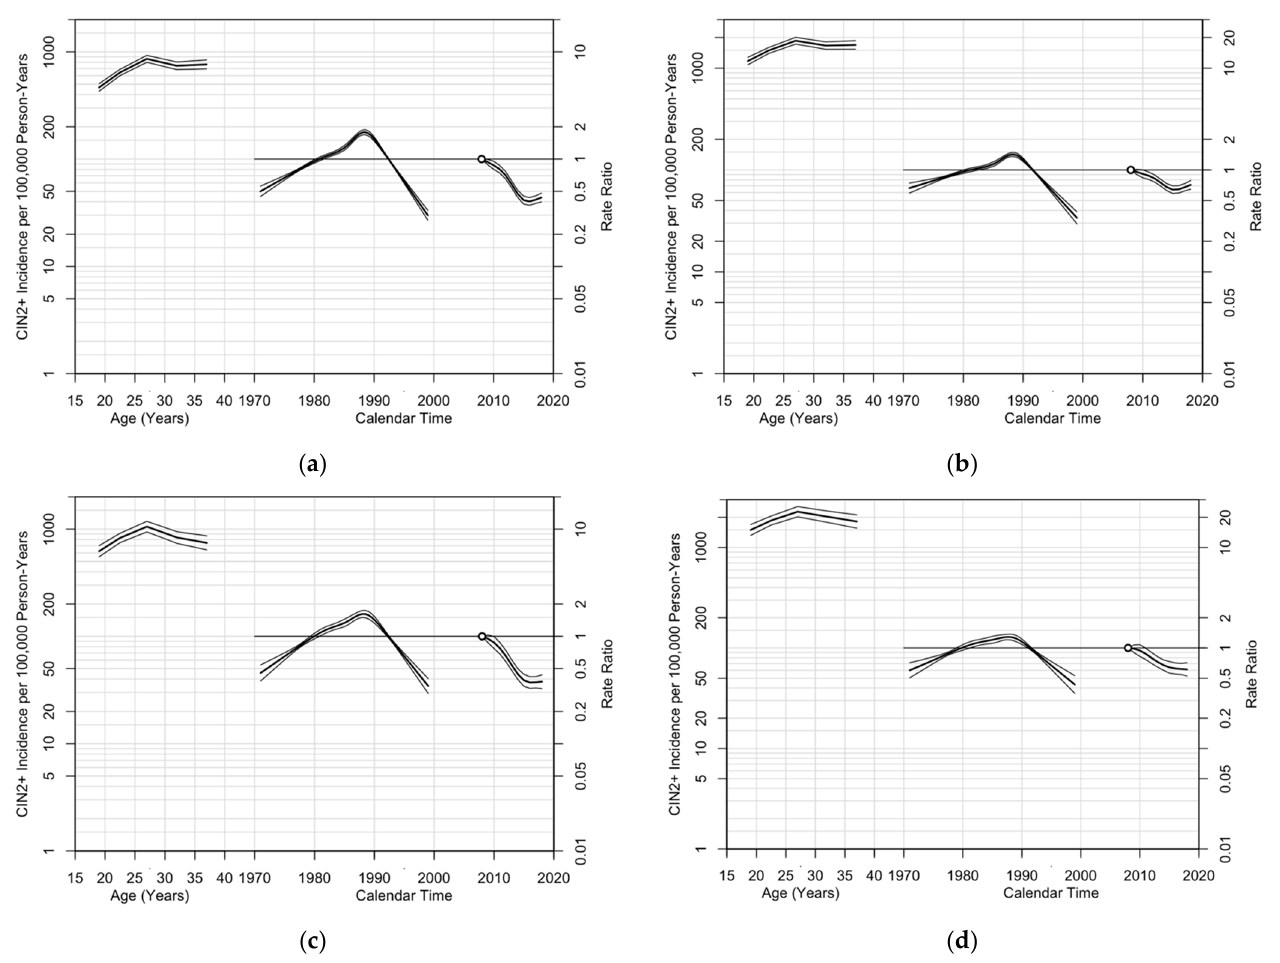
Figure 4. Age, cohort, and period effects 1 among ( a ) all women enrolled in Tennessee Medicaid residing in MSAs; ( b ) the subset of women screened for cervical cancer residing in MSAs; ( c ) all women enrolled in Tennessee Medicaid residing in non-MSAs; ( d ) the subset of women screened for cervical cancer residing in non-MSAs. CIN2+: cervical intraepithelial neoplasia grades 2 and 3 and adenocarcinoma in situ; MSA: metropolitan statistical area. 1 Each plot’s horizontal axis is divided into two parts: age, ranging from 15–40 years (left), and calendar time, ranging from 1970–2020 (right). Each plot contains two vertical axes: CIN2+ incidence per 100,000 person-years (left) and rate ratios (right), and three sets of curves: age effects, interpretable as cross-sectional CIN2+ incidence rates per 100,000 women at risk for the reference period, 2008, adjusted for cohort effects, with corresponding 95% confidence intervals (left), cohort effects, constrained to be 0 on average with 0 slope, interpretable as rate ratios relative to the age–period predictions (i.e., residual rate ratios) with corresponding 95% confidence intervals (middle), and period effects, interpretable as rate ratios relative to the reference period, 2008 (indicated by the hollow circle), with corresponding 95% confidence intervals (right).